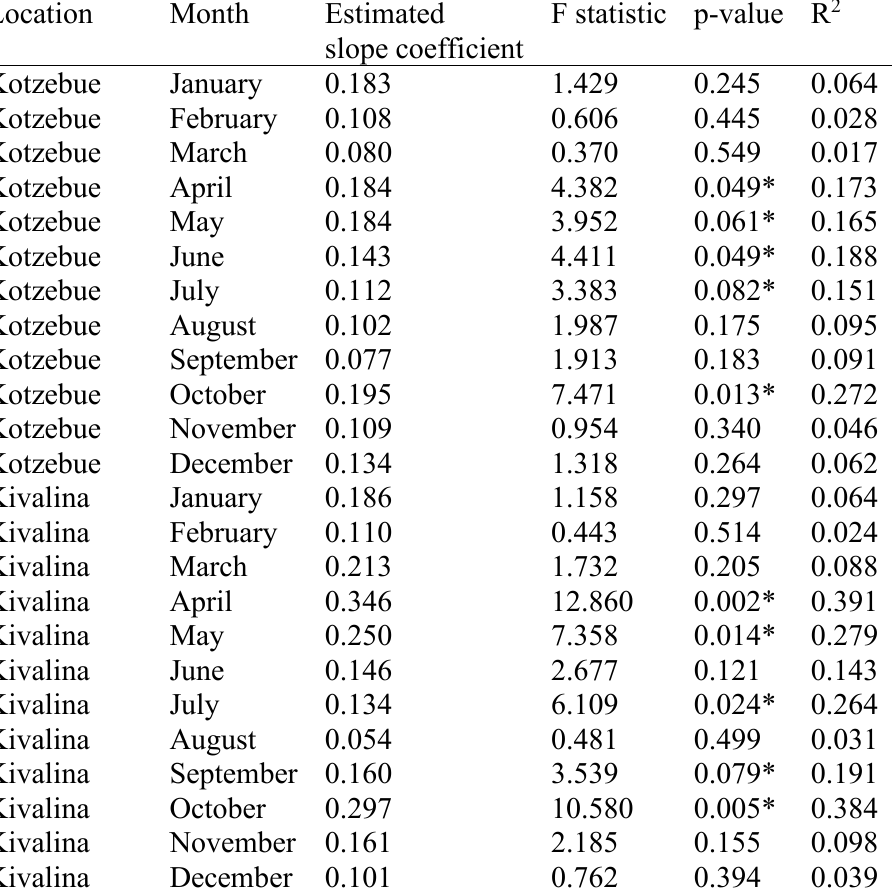
Table A2.2 Estimated slope coefficients, F statistics, p-values, and R 2 values for fitted linear regression models of monthly mean air temperature versus year for Kotzebue and Kivalina. Significant regression fits (p < 0.1) are marked with an